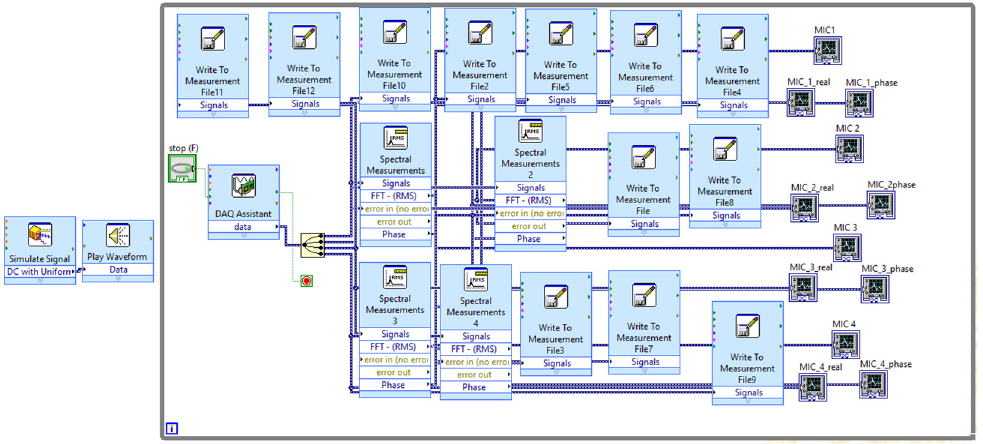
Figure 5. LabVIEW program for data acquisition.